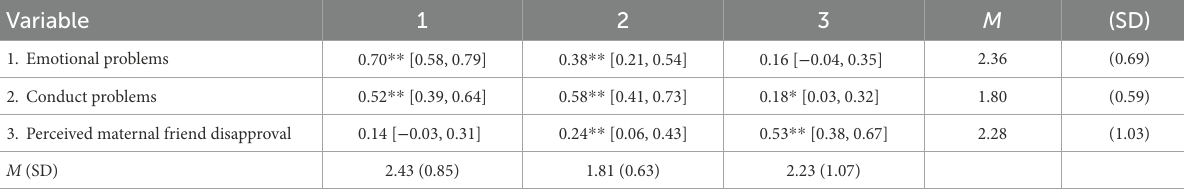
N = 142 randomly selected individuals from each friend dyad. 95% Confidence intervals are presented in brackets. Autocorrelations are presented on the diagonal. Intercorrelations at Fall are above the diagonal. Intercorrelations at Spring are below the diagonal. Variables were rated on a scale from 1 (never) to 5 (always). * p < 0.05, ** p < 0.01,